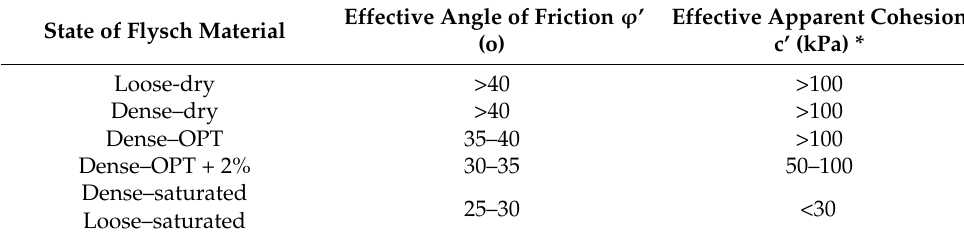
Figure 7. Large shear failure envelopes of the tested flysch specimens. PAN ( a ), KAR1 ( b ), KAR2 ( c ), PLAT1 ( d ) and PLAT2 ( e ). Table 4. Summary of effective angles of friction of flysch as determined by large shear tests.